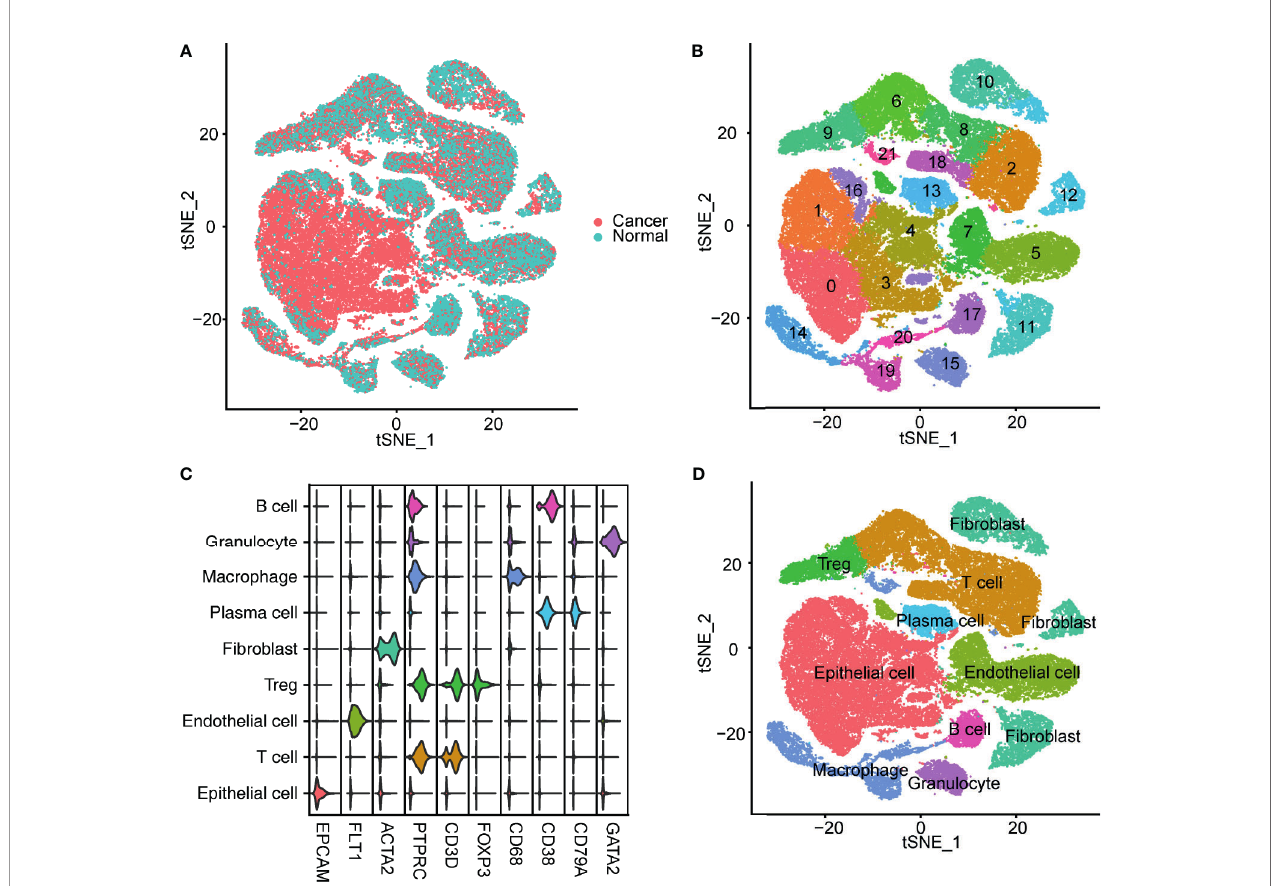
FIGURE 1 | Identi fi cation of bladder cancer cells in single-cell sequencing data. (A) T-SNE plot of the integrated bladder cancer single-cell data. Each point represents a cell. Points were colored according to the pathological tissue type. (B) T-SNE plot of the cell clusters identi fi ed by the clustering algorithm. Points were colored according to the cluster identity. (C) Violin plot of the expression of classical markers of each cell type. (D) T-SNE plot of the annotated cell clusters. Each point represents a cell. Points were colored according to the cell